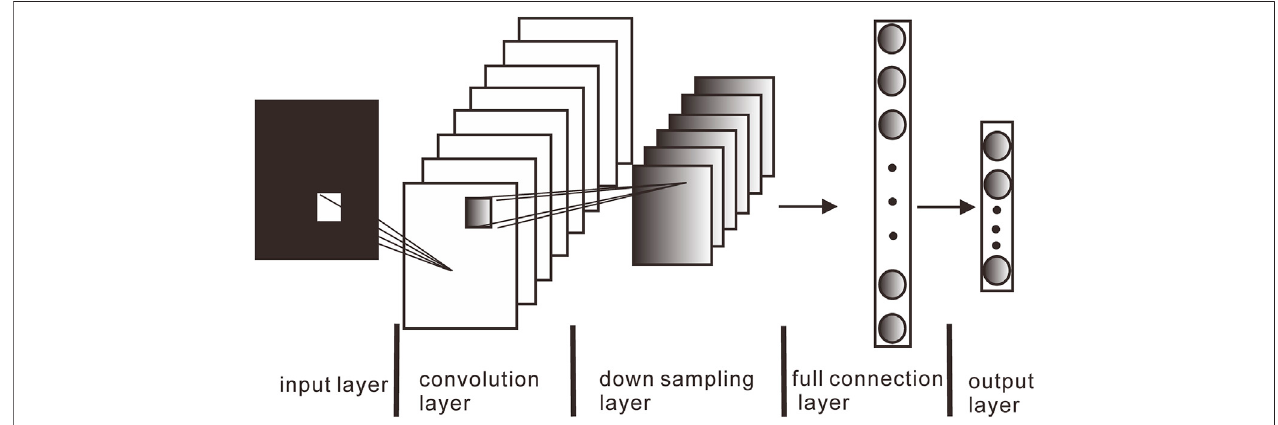
FIGURE 3 | Typical structure of convolution neural network (Wang et al.,